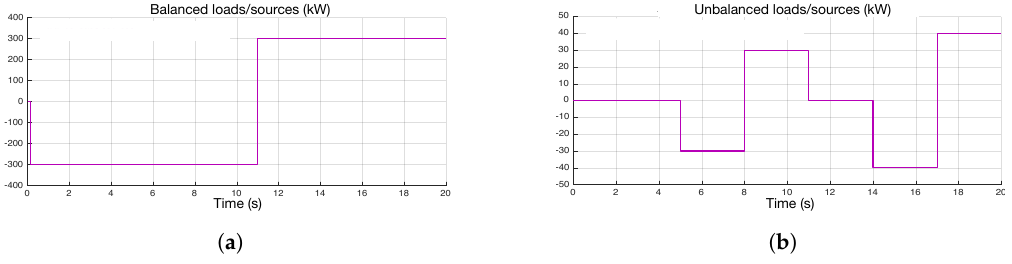
Figure 12. Simulation current of equivalent loads/sources. ( a ) balanced loads/sources; ( b ) unbalanced